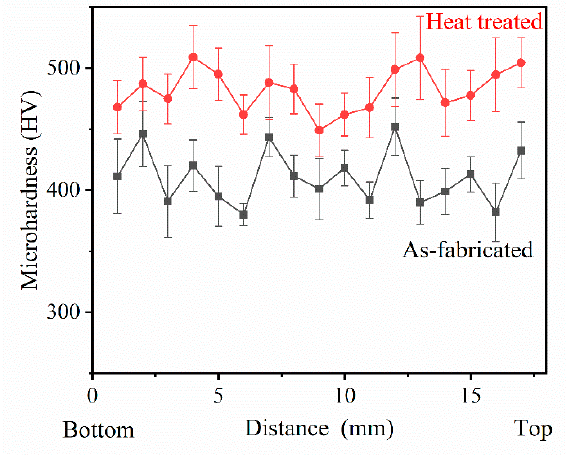
Figure 15. Microhardness of the AF and HT samples depending on their distance from the bottom.